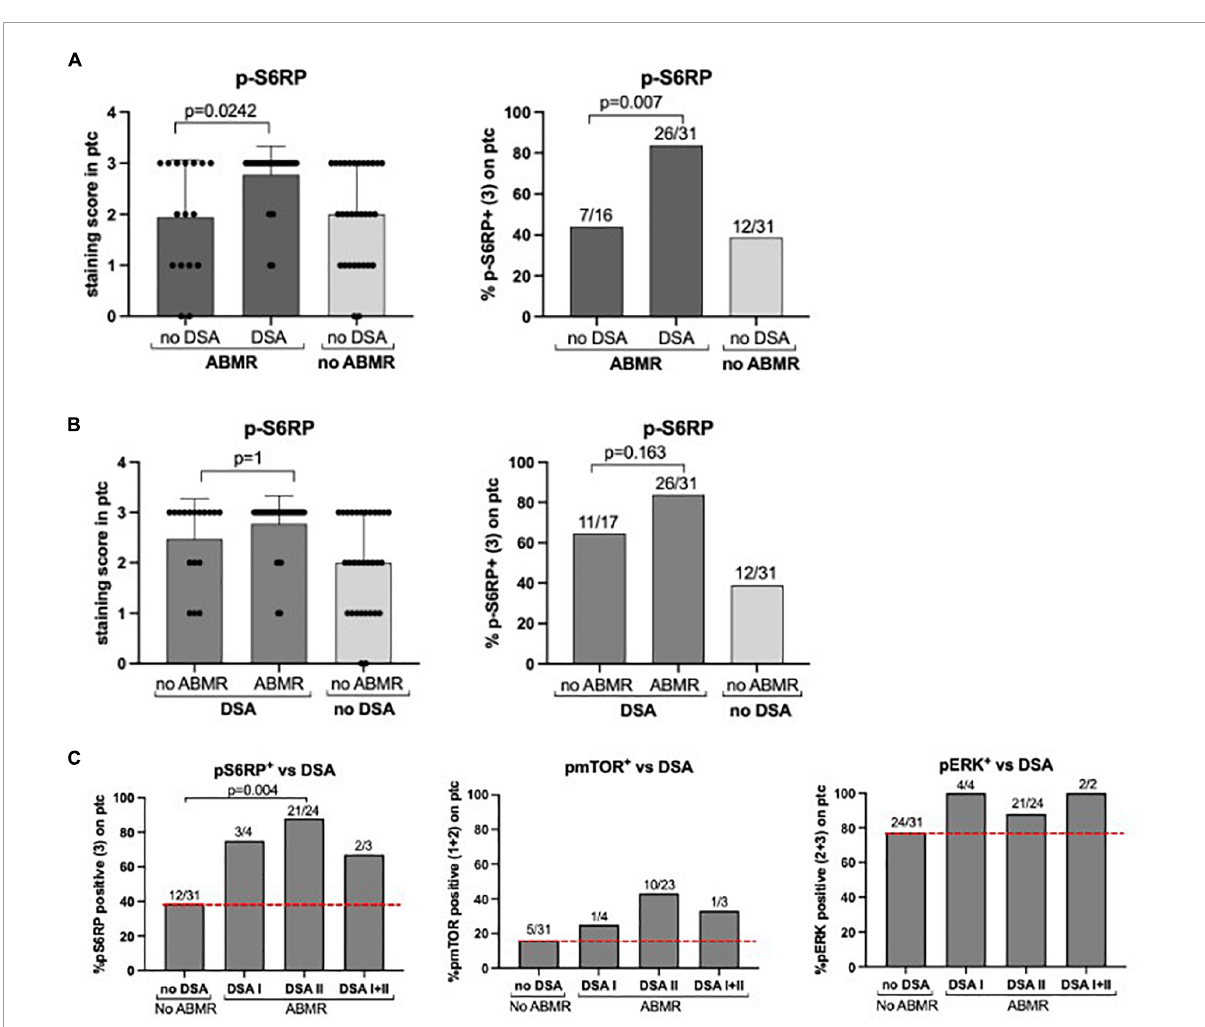
FIGURE5 P-S6RP in peritubular capillaries is associated with HLA-DSA. (A) Comparison of p-S6RP staining score in biopsies compatible with ABMR with DSA ( n = 31) and with no detectable HLA-DSA ( n = 16). (B) Comparison of p-S6RP staining score in biopsies with DSA and ABMR ( n = 31) with biopsies with HLA-DSA but not ABMR ( n = 18). Plots show the means (bars), standard deviation (error bars), and individual values (dots) for each sample. Mann Whitney test was used to assess significant differences between groups. (C) Percentage of positive staining (bars) for p-S6RP, p-mTOR, and p-ERK on biopsies with DSA class I, II, or I&II compared to biopsies with no DSA and no rejection (red dotted line).